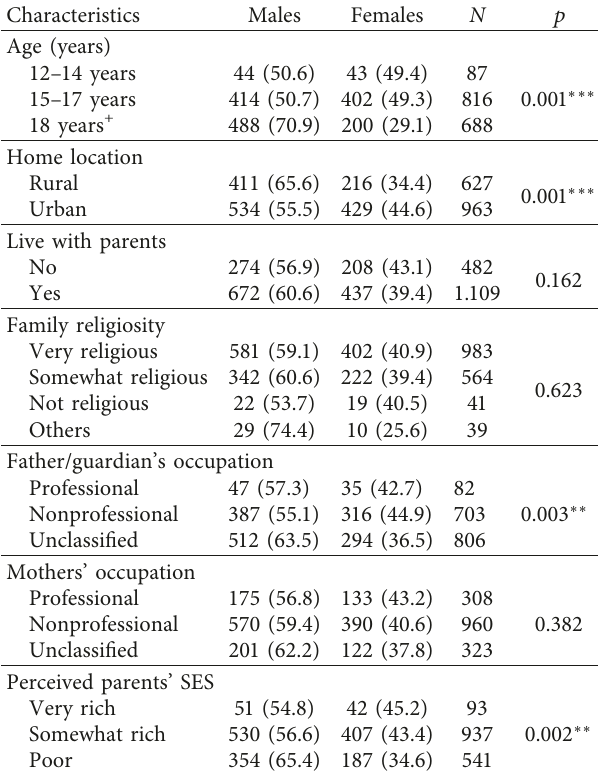
Table 1: Frequency distribution of sociodemographic and family factors of adolescents in public secondary schools in Uganda ( N � 1.591).